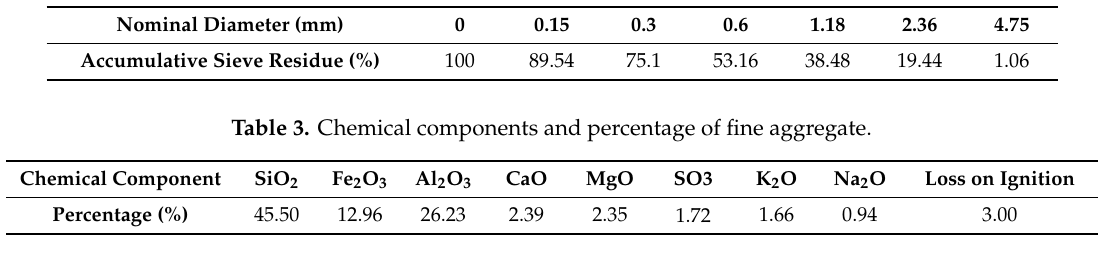
Table 4. Chemical components and percentage of silica fume.